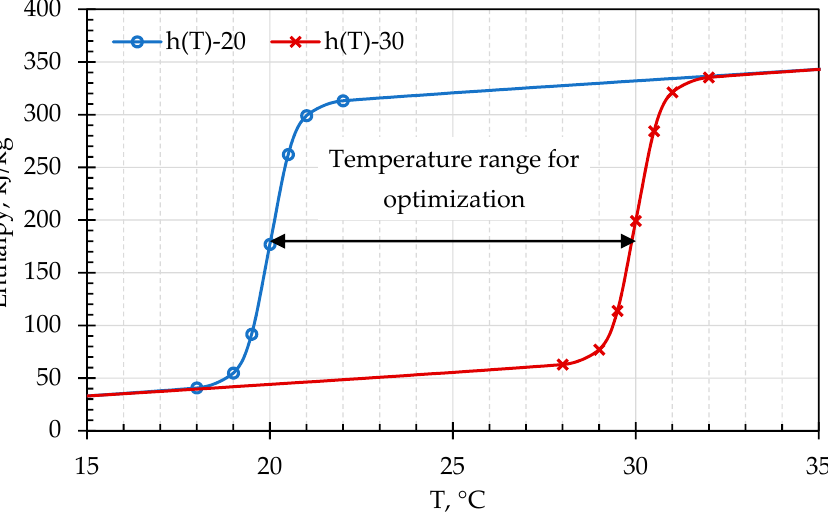
Figure 9. Enthalpy-temperature curves of PCMs for search domain used in optimization.